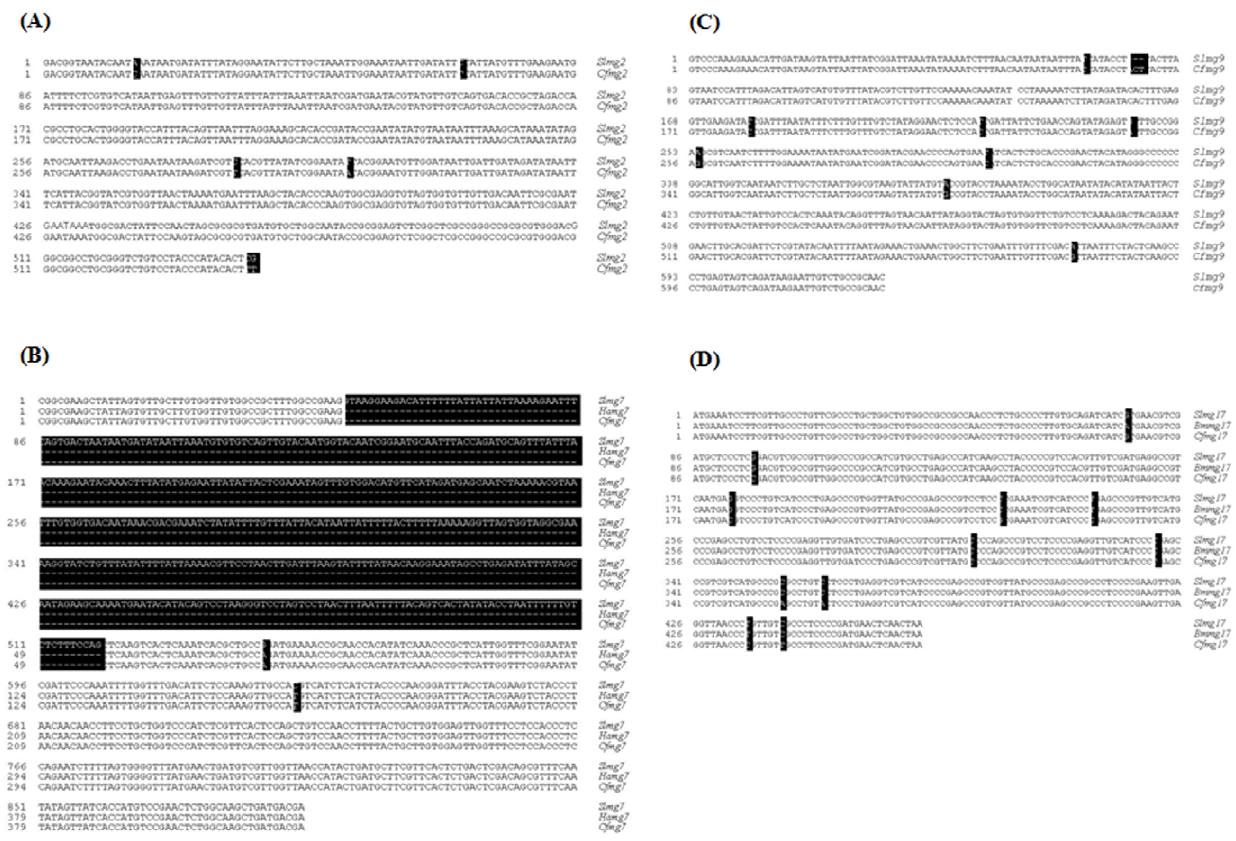
Figure 4. Sequence alignment analysis of the four larval midgut-predominant genes. Alignment of Slmg2 (A), Slmg7 (B), Slmg9 (C) and Slmg17 (D), with their homologues in other lepidopteran species. Those different nucleotides among the sequences are labelled in black background with white letters. Sl: Spodoptera litura ; Bm: Bombyx mori ; Ha: Helicoverpa armigera , Cf: Choristonera fumiferana . The GenBank accession numbers of these cDNA are JF964956 for Slmg2 , JF964955 for Slmg7 , JF964957 for Slmg9 and JF964954 for Slmg17 , respectively. The GenBank accession numbers of their homologous genes in other species are JN656431 for Cfmg2 , JN656432 for Cfmg7 , JN656433 for Hamg7 , JN656434 for Cfmg9 , JN656435 for Cfmg17 and JN656436 for Bmmg17 .